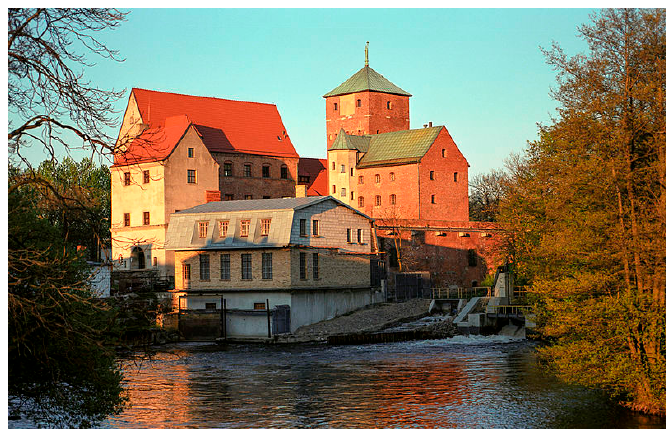
Figure 12. The Pomeranian Dukes’ Castle in Darłowo today, photo: Jerzy Strzelecki, source: Wikimedia Commons.